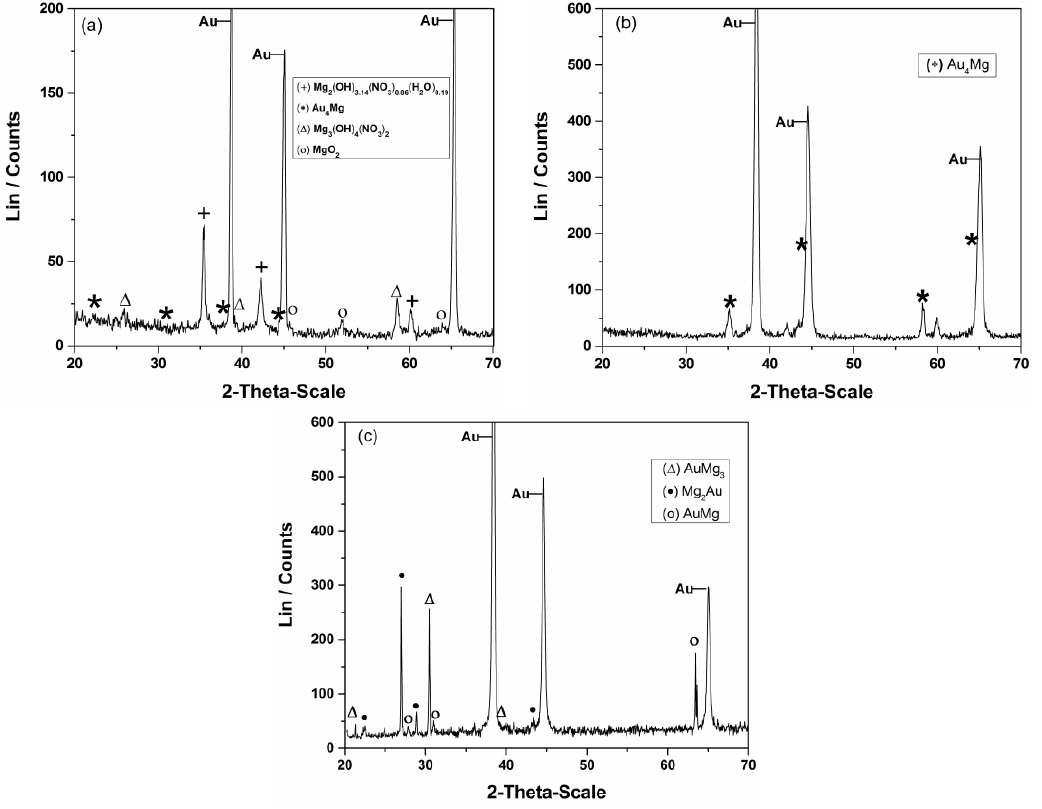
Figure 5. Diffraction patterns of gold samples after magnesium underpotential deposition at E x = +0.100 V in: ( a ) magnesium/ammonium nitrate eutectic mixture at 400 K for 2 h; ( b ) [47] and ( c ) nonaqueous magnesium/ammonium eutectic mixture melt at 460 K for 2 h and 5 h, respectively.